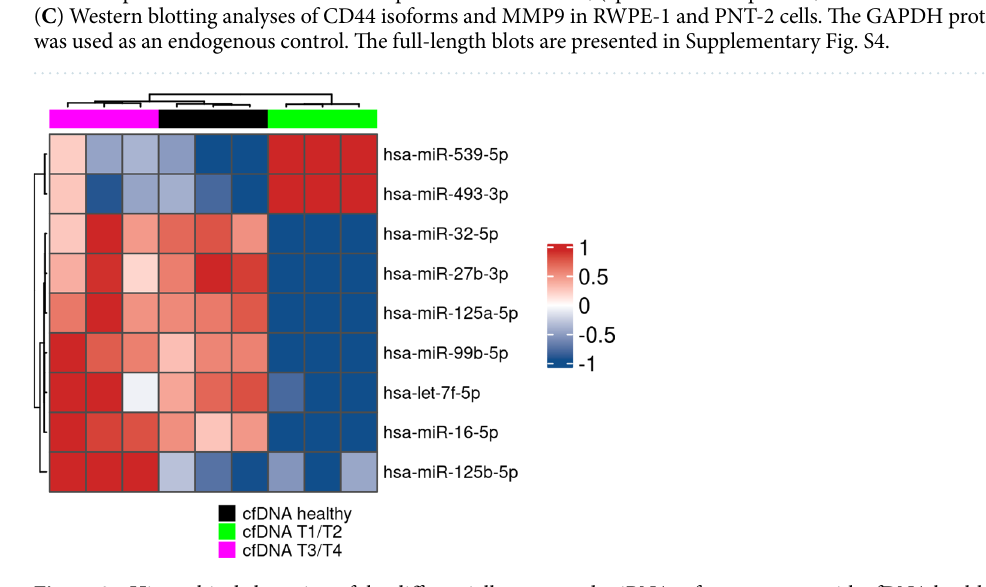
Figure 2. Effect of plasma cfDNA from prostate cancer patients on the expression of genes associated with the epithelial-mesenchymal transition in RWPE-1 ( A ) and PNT-2 ( B ) cells. Twenty nanograms of cfDNA were incubated with 1 × 10 5 cells for 24 h. Gene expression was determined by RT-qPCR and data are reported as fold change increase of gene expression compared to control cells untreated with cfDNA. The dotted line represents control expression set to 1. Results are expressed as mean ± S.D, (*p < 0. 05 and **p < 0.01; Kruskal–Wallis test).